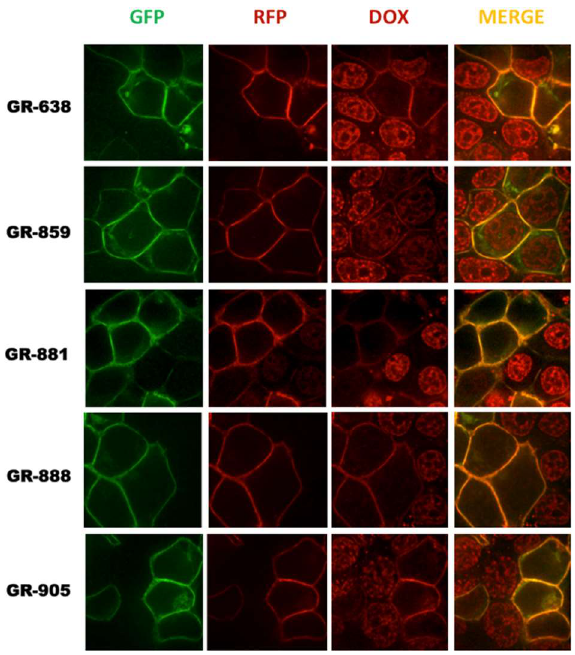
Figure 4. Doxorubicin (Dox) accumulation assay. HEK293T cells were transiently transfected with six different two-color MRP1 constructs and incubated for 48 h, after which doxorubicin treatment was done. Images were taken using a confocal microscope equipped with a 63× objective. GFP and Dox were excited at 470 nm wavelength using an Ar laser, with emission bands of 480–530 nm for GFP and 573–637 nm for Dox. RFP was excited at 561 nm, and its emission was collected at 580–669 nm. Data were collected from all three channels—GFP, RFP and Dox. RFP and Dox have significant emission wavelength overlap, explaining the membranous signal seen for the two-color MRP1 recombinant proteins in the Dox channel.